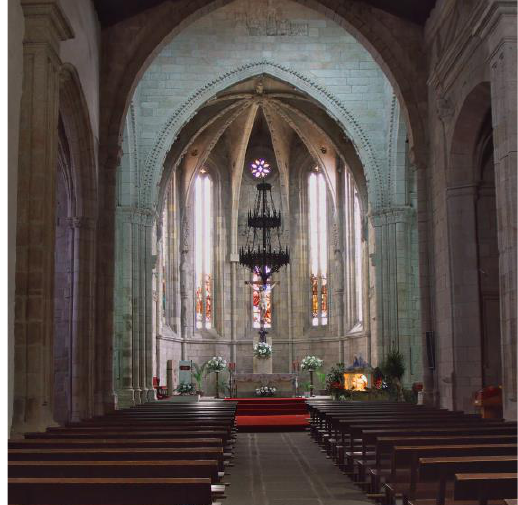
Figure 1. San Francisco Gothic apse. Indoors. (Pérez Ramos,